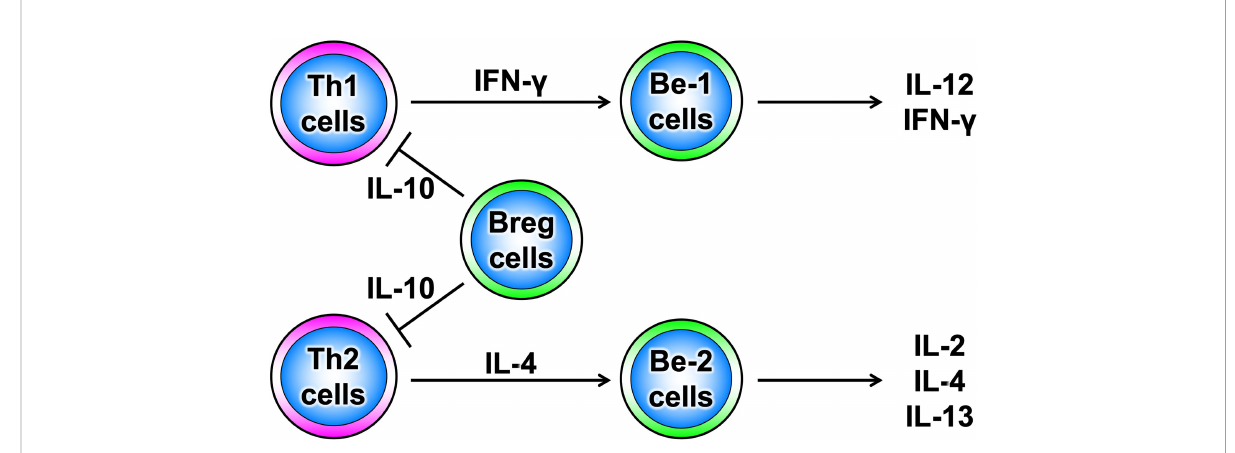
FIGURE 3 Diversity of B-cell subsets. As with T cells, B cells have subsets that are classi fi ed according to the cytokines they produce and are thought to function